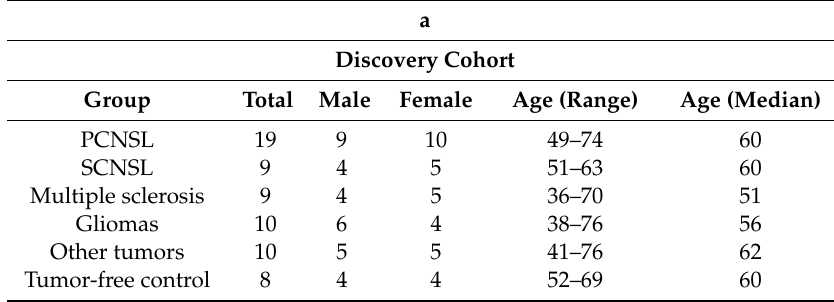
Table 1. Demographic data of participating individuals. ( a ) Discovery study cohort, ( b )